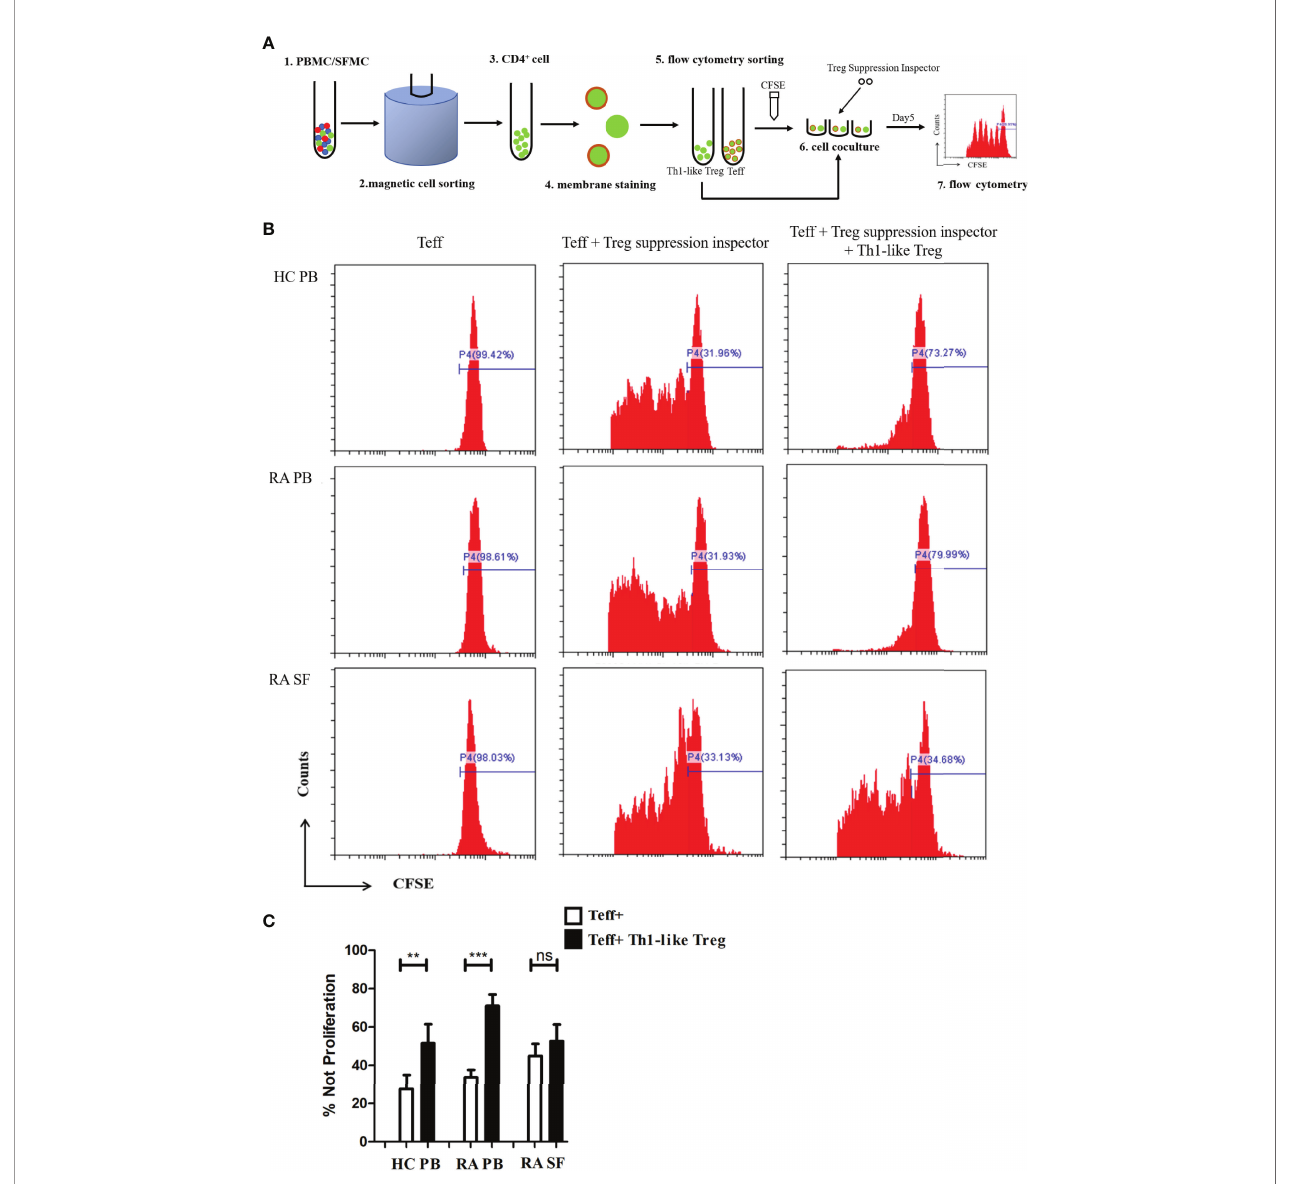
FIGURE 5 | Th1-like Treg cell suppression assay in vitro . (A) Schematic of the Treg in vitro suppression assay. (B) Histograms of Teff cell proliferation from HC PB, RA PB, and RA SF under different conditions. (C) Comparison of the suppression of Teff cell proliferation by Th1-like Treg cells from HC PB, RA PB, and RA SF. Data are from 11 RA patients, 4 healthy donors and 5 SF samples. ** p < 0.01, *** p < 0.001, ns, not statistically signi fi